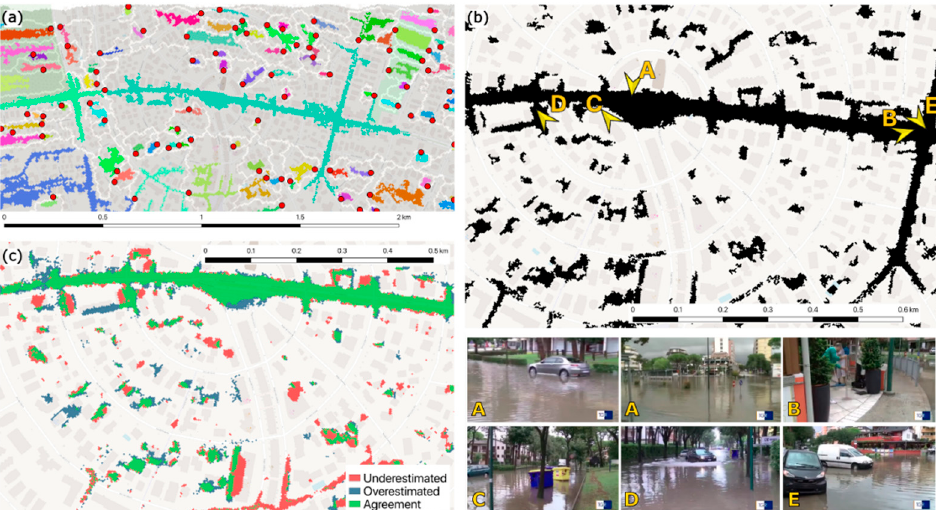
Figure 6. Results of the application of Safer_RAIN to the case study of Lignano Sabbiadoro: ( a ) identification of blue-spots (binary maps, where each blue-spot is marked with a different color), spilling points (red dots) and watersheds (white lines); ( b ) identification of the flooded area resulting from the rainfall depth of 124 mm recorded for the urban flash-flood of the 11 September 2017; pictures (source: local TV-news footage, TGR Friuli Venezia Giulia) are provided for some points to highlight the ground evidence of flooded area; ( c ) comparison with a hydrodynamic model (red, blue and green colors indicate underestimation, overestimation and agreement, in this order).